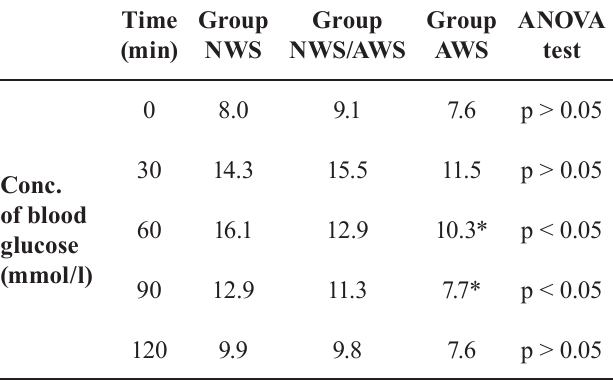
FIGURE 1 - Postprandial glycemic response of three experimental mice